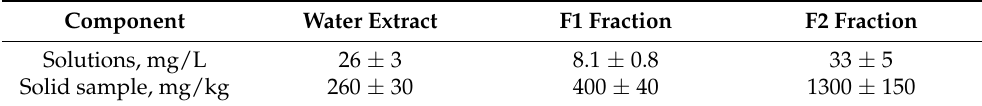
Table 6. Comparison of the content of water-soluble